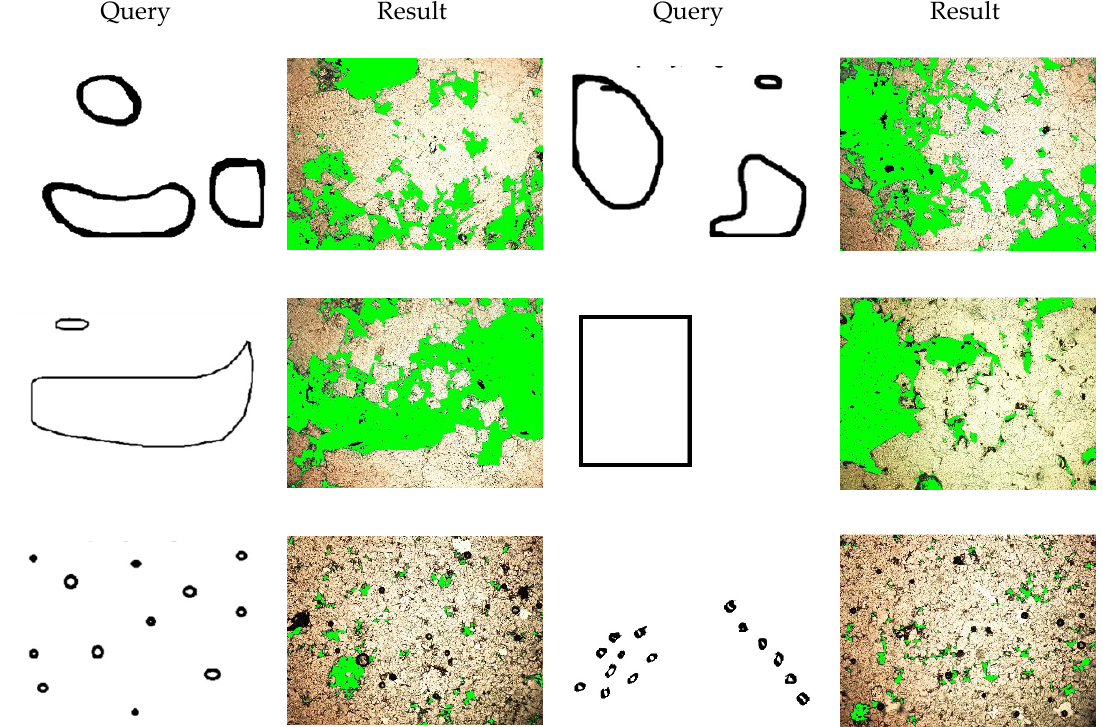
Figure 7. An example of the retrieval results of the most similar object / image from the analysed database, for the particular sketch query.